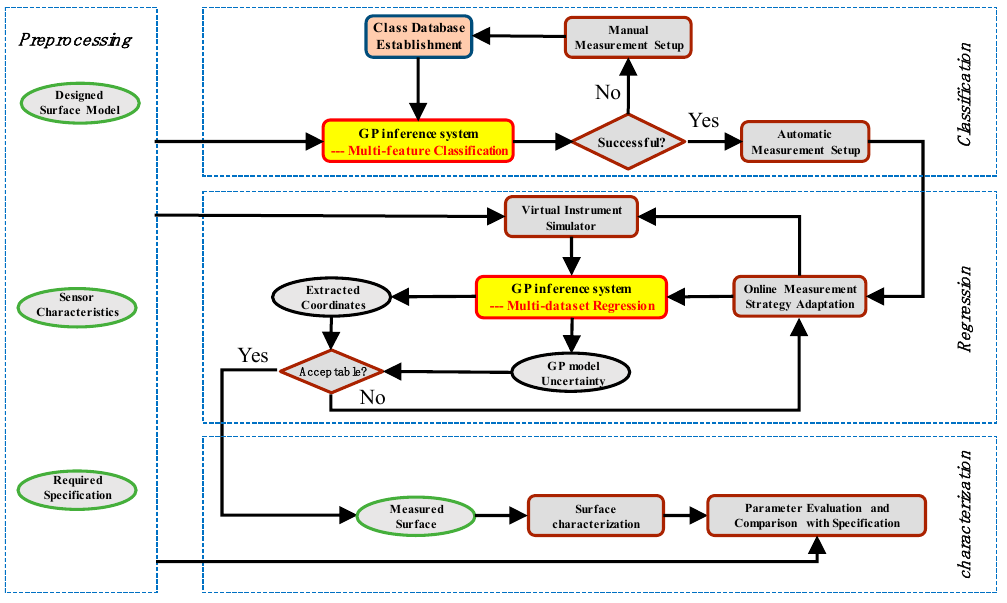
Figure 2. Schematic diagram of GP-BIS.